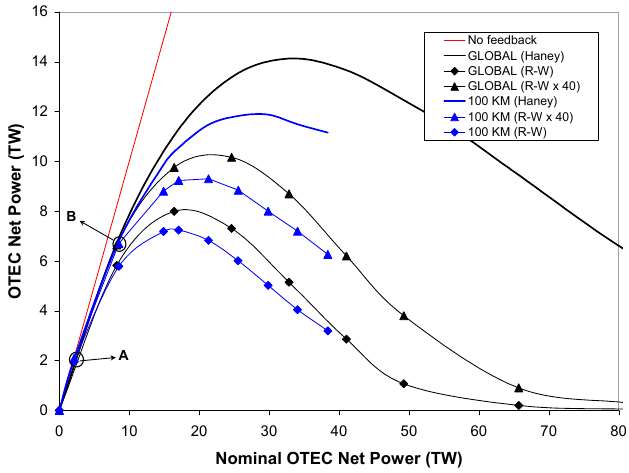
Figure 3. Long-term OTEC power production as a function of nominal OTEC power for different implementation scenarios and ocean-atmosphere thermal boundary conditions.